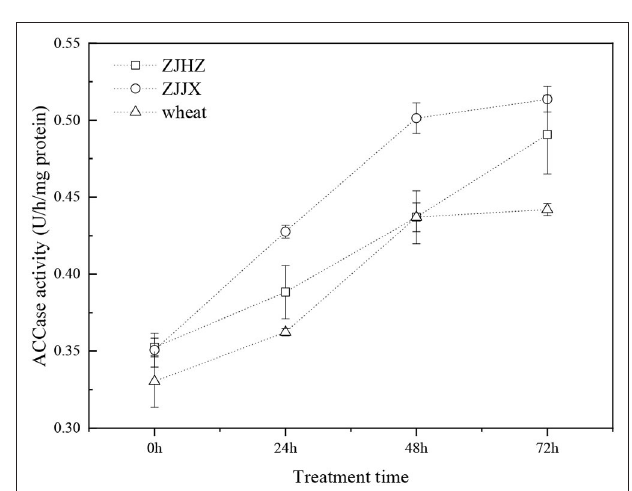
FIGURE 4 | ACCase activity in wheat and common roegneria populations ZJJX and ZJHZ at 0, 24, 48, and 72h after fenoxaprop- P -ethyl treated. Data are the means ± SE from five replicates of two experiments ( n =